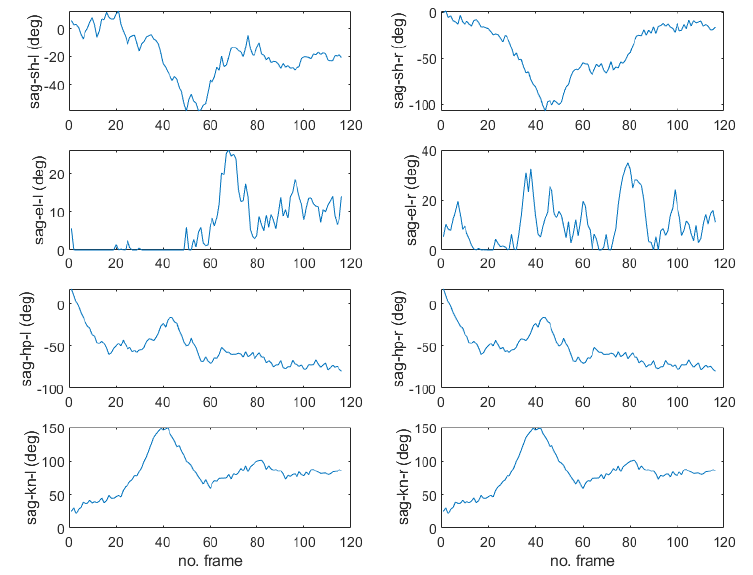
Figure 9. Angular trajectories (in degrees) of the shoulder, elbow, hip, knee joints in the sagittal plane identified for the sitting and standing motion.